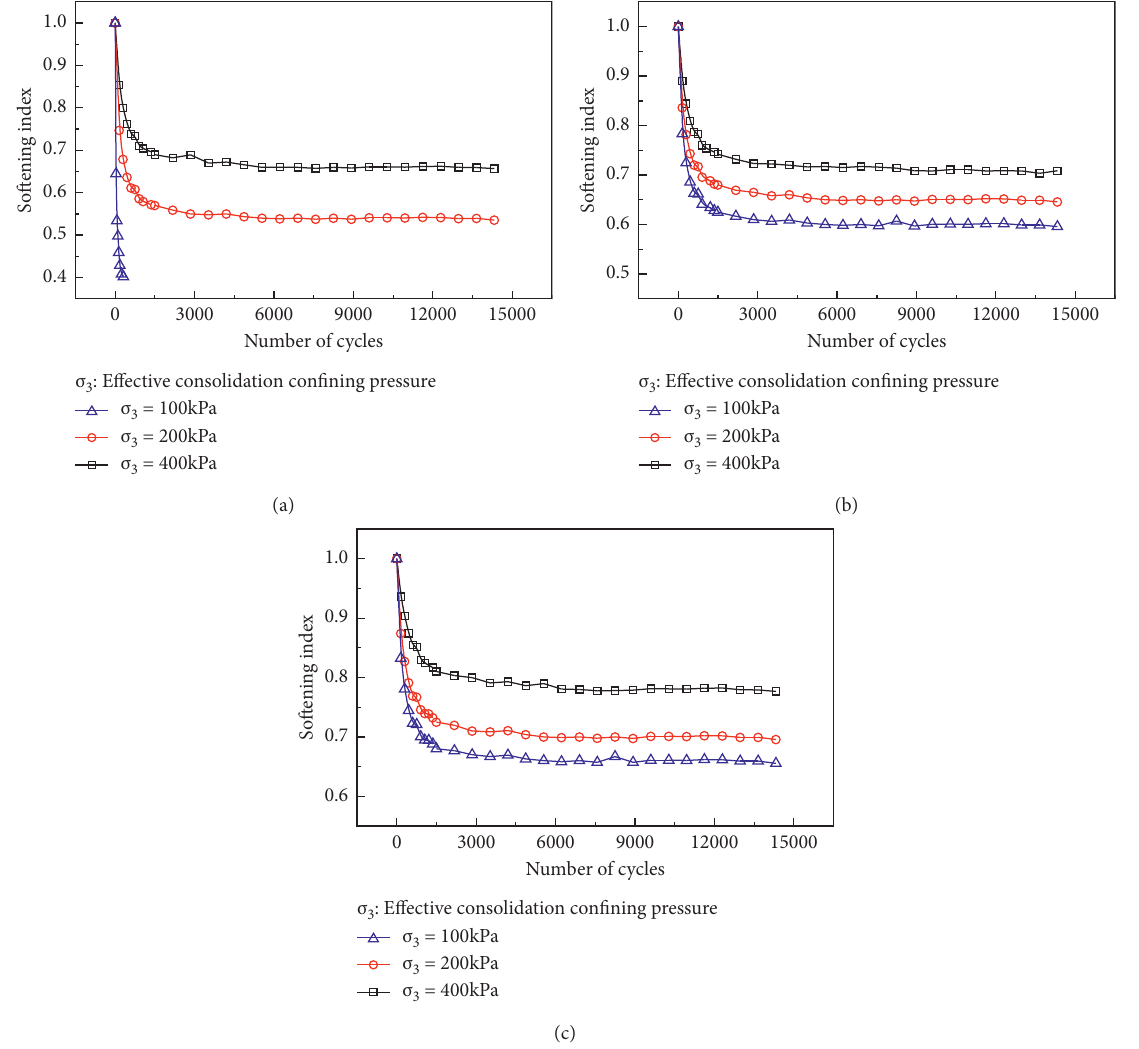
Figure 9: Effective confirming pressures effect on the softening index of SRM: (a) P � 20% and U � 0 . 80; (b) P � 20%and U � 0 . 90; (c) P � 20% and U � 0 . 98.